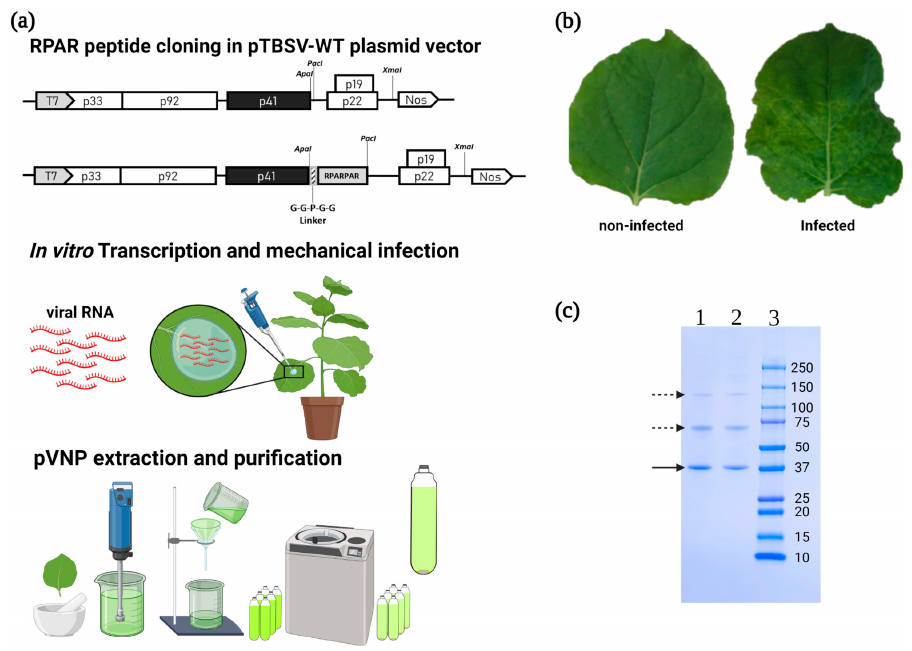
Figure 1. Preparation of TBSV-RPAR expression construct and recombinant virus production. Ex- perimental flow-chart: the TBSV CP (p41) is genetically engineered by fusion of the RPAR peptide coding sequence in the pTBSV-WT plasmid vector; the modified TBSV vector is transcribed in vitro to obtain an infectious viral RNA to be used for plant inoculum; infected tissue is used for virus purification, and purified batches are controlled by SDS-PAGE. ( a ) Map of the TBSV–WT/RPAR plasmids, RNA inoculum in planta , and pVNP purification procedure. The five ORFs (p33 and p92 (RNA-dependent RNA polymerase), p41 (coat protein, CP), p22 (movement protein), p19 (silencing inhibitor)) are shown. T7, promoter sequence from T7 phage; Nos, terminator sequence of the Agrobacterium tumefaciens nopaline synthase encoding gene; ApaI and PacI , restriction sites used for RPAR CP genetic fusion; XmaI , restriction site used for vector linearization; striped box, GGPGG linker. ( b ) N. benthamiana leaves from non-infected plants (left) and after infection with TBSV-RPAR (right). ( c ) SDS-PAGE of TBSV-RPAR NPs. Purified TBSV samples (4 µ g per lane) were denatured and electrophoretically separated on 4–20% Tris-glycine gel (Bio-Rad), stained with Coomassie Blue. TBSV-WT (1), TBSV-RPAR (2), Precision Plus Protein Dual Color Standards (Bio-Rad) (3). The molec- ular masses of the marker bands are indicated. Solid arrow indicates monomeric coat protein bands; dashed arrows indicate CP dimers and